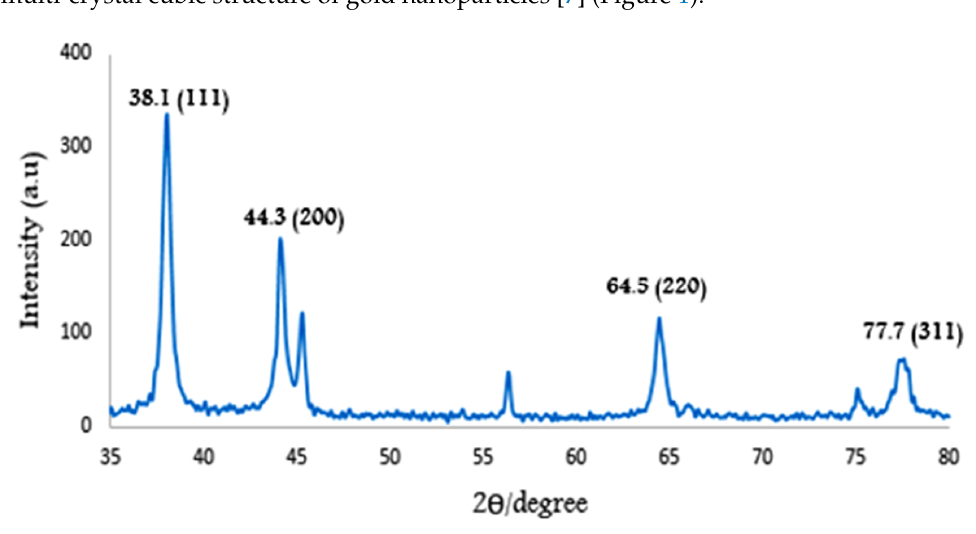
Figure 2. FESEM image of Au NPs synthesized by E. coli TOP-10. 2.1.3. AFM Analysis Figure 3 shows the size distribution of the synthesized gold nanoparticles. Gold na- noparticles with sizes of 30.4 nm were used for chemical synthesis.